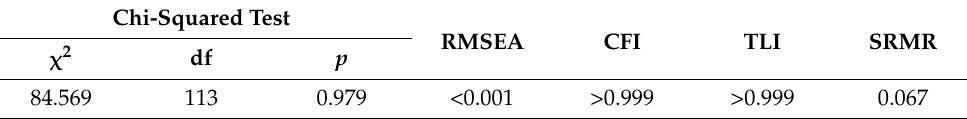
Table 4. Results of the confirmatory factor